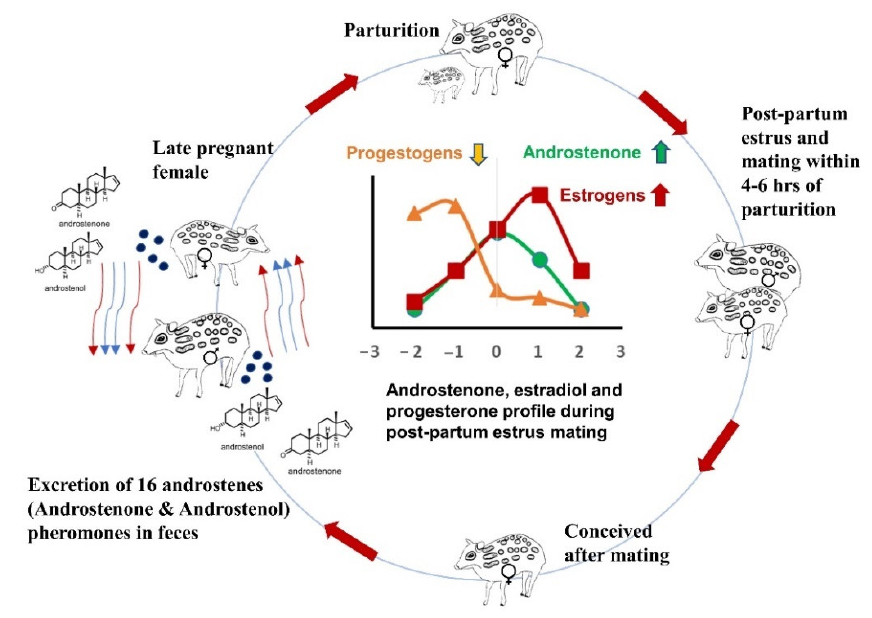
Figure 12. The graphical representation of a model how androstenone (16-androstenes), estrogens, and progestogens play a crucial role during parturition, postpartum estrus, and mating in mouse deer.